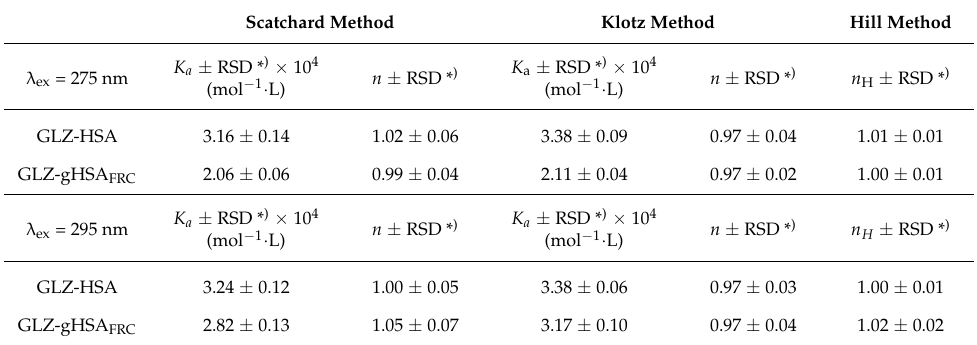
Table 3. Association constants K a (mol − 1 · L), mean number of GLZ moles bound with one mole of HSA and gHSA FRC ( n ), and the Hill’s coefficient ( n H ) in GLZ-HSA and GLZ-gHSA FRC systems; λ ex = 275 and λ ex = 295 nm.